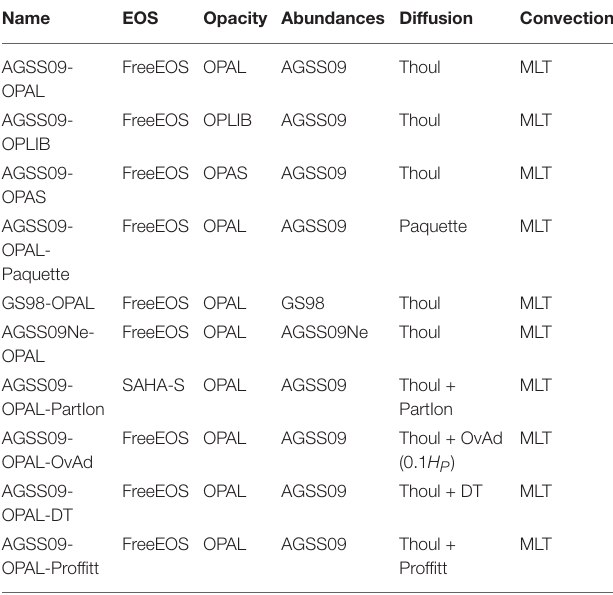
TABLE 1 | Physical ingredients of the standard solar models used in this